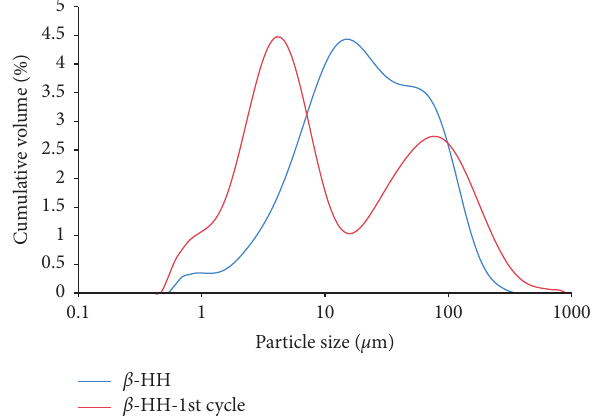
Figure 4: Particle size distribution of pure β -HH and β -HH after the first